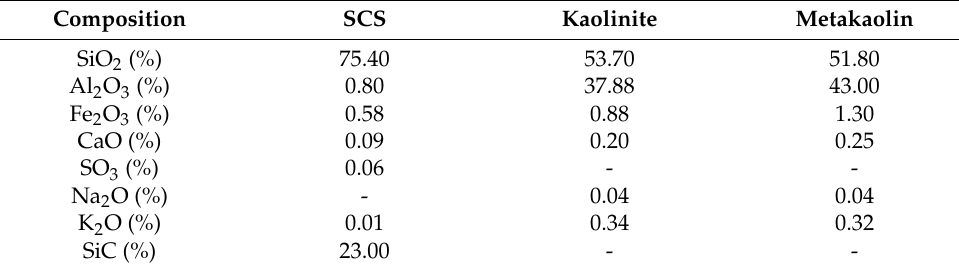
Table 1. The composition of